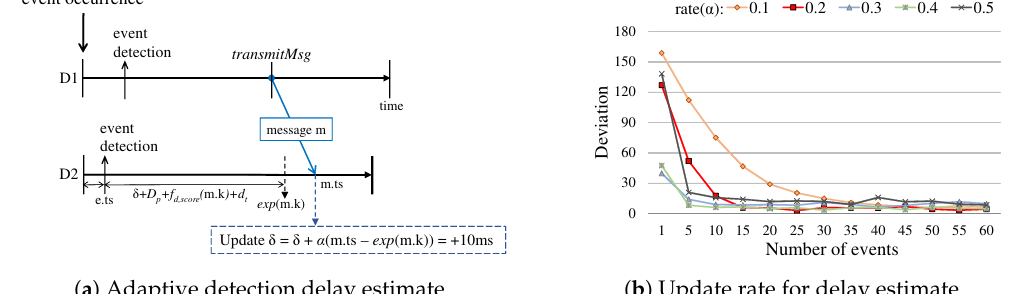
Figure 9. Adaptive mechanism of event detection delay: ( a ) an example of how to update the temporal difference δ between the event detection delay of a device and the framework parameter D e , the expected detection delay, using the message m and its score k received; and ( b ) the impact of α values, different update rates, along with the event occurrences over time. The simulation experiment was performed over 60 subsequent event occurrences for each update